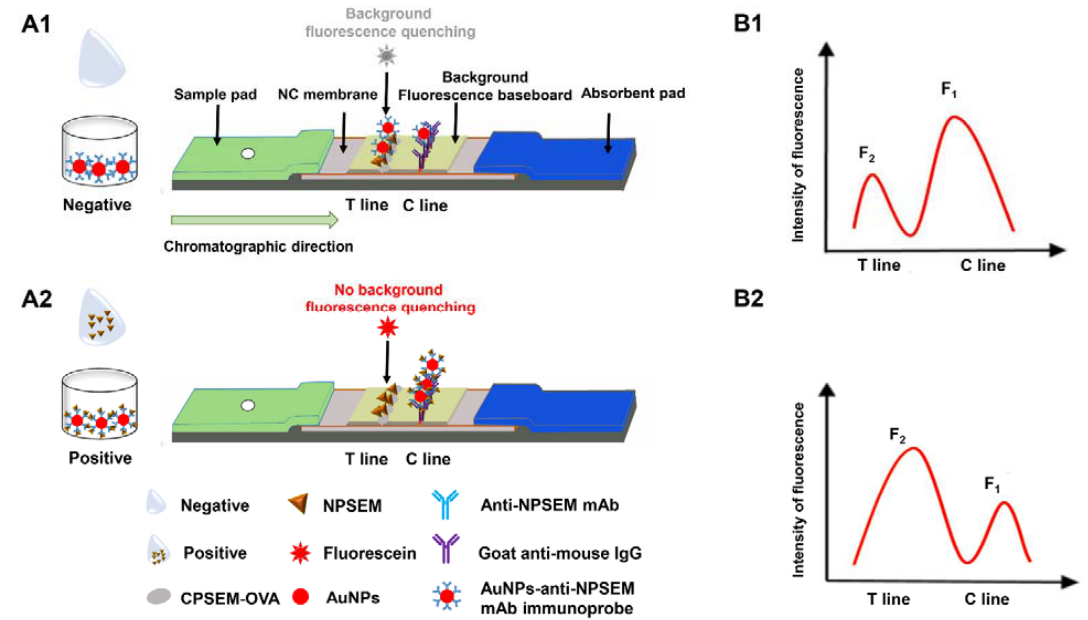
Figure 2. Scheme of bFQICA for the quantitative detection of (NP)SEM. ( A ): The diagram of bFQICA test card, when there was no (NP)SEM (negative) ( A1 ), or when there was in the presence of (NP)SEM (positive) ( A2 ); ( B ): the fluorescence of C line (F 1 ) and T line (F 2 ), when there was no (NP)SEM (negative) ( B1 ), or when there was in the presence of (NP)SEM (positive) ( B2 ).